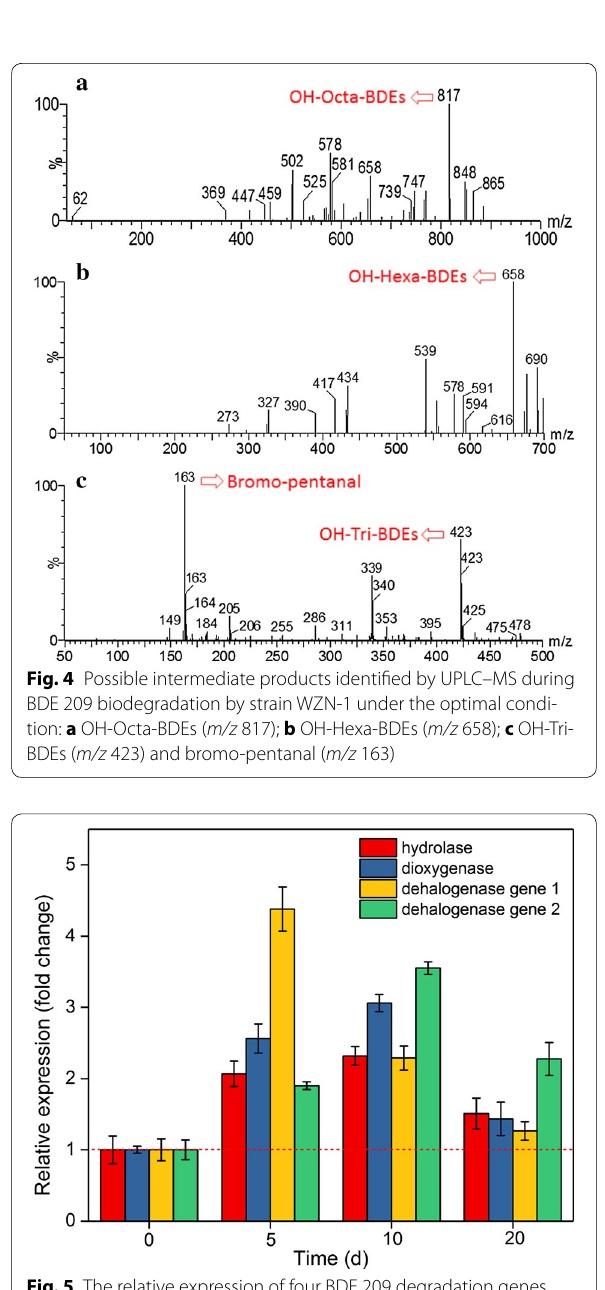
Fig. 5 The relative expression of four BDE 209 degradation genes during the degradation